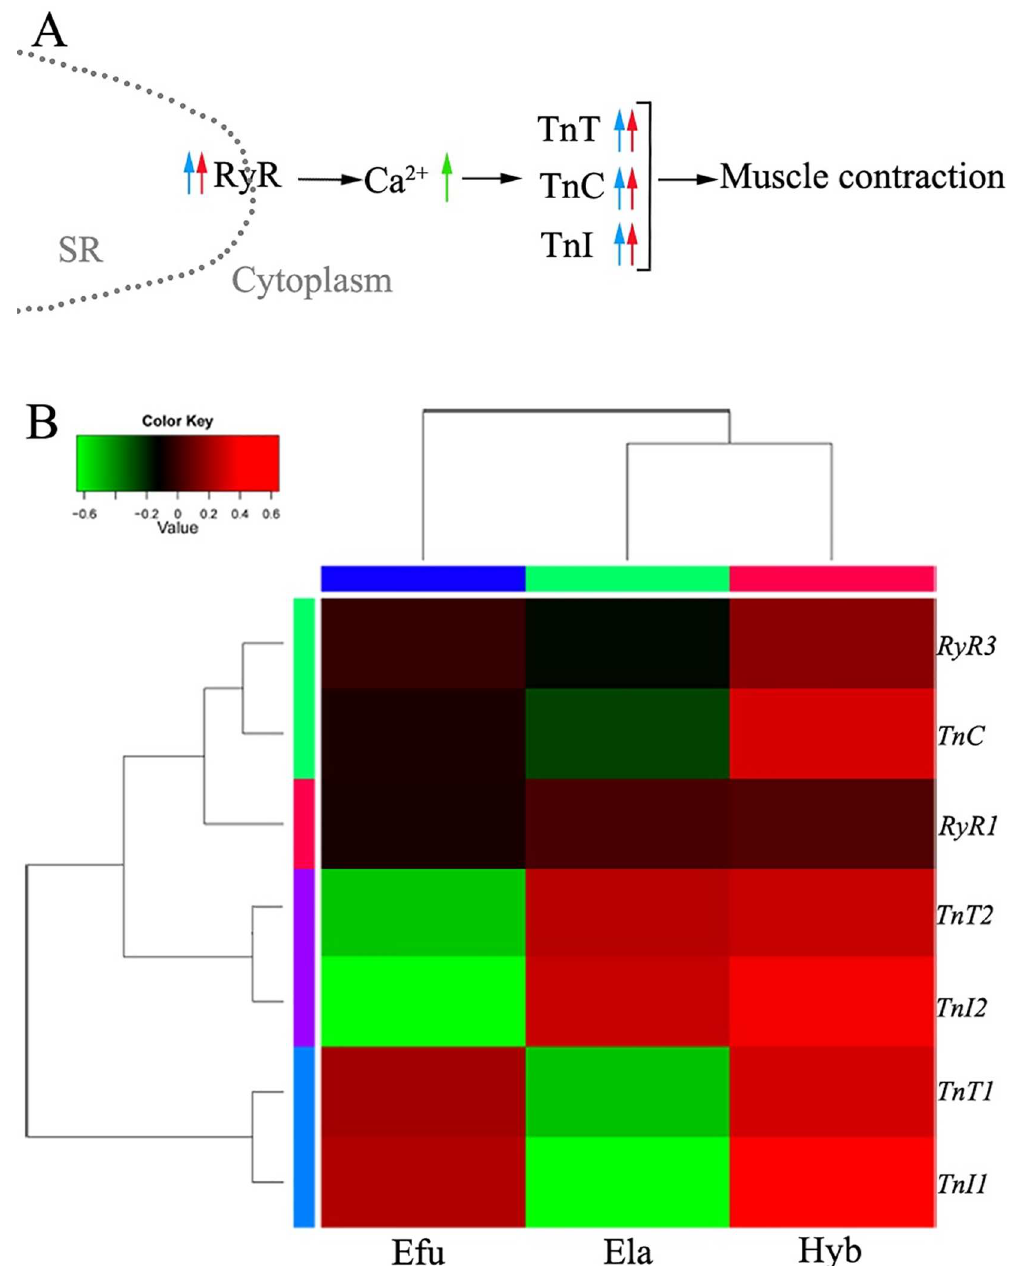
Fig 3. Ca 2+ signal was activated by RyRs, with downstream troponin proteins up-regulated in the Hyb. (A) Diagramrepresentingthe related Ca 2+ signaling pathway and the interaction betweencalcium and troponins. Blue arrows denote the expressiondifferences betweenthe Hyb and paternal Ela. Red arrows denote the expression differences betweenthe Hyb and maternalEfu. Up arrows stand for up-regulation of transcription in the Hyb. The green up arrow denotesthe increasing Ca 2+ concentration in the cytoplasm. (B) Hierarchical cluster analysisof Ca 2+ regulatinggenesand troponins. The color key represents RPKM